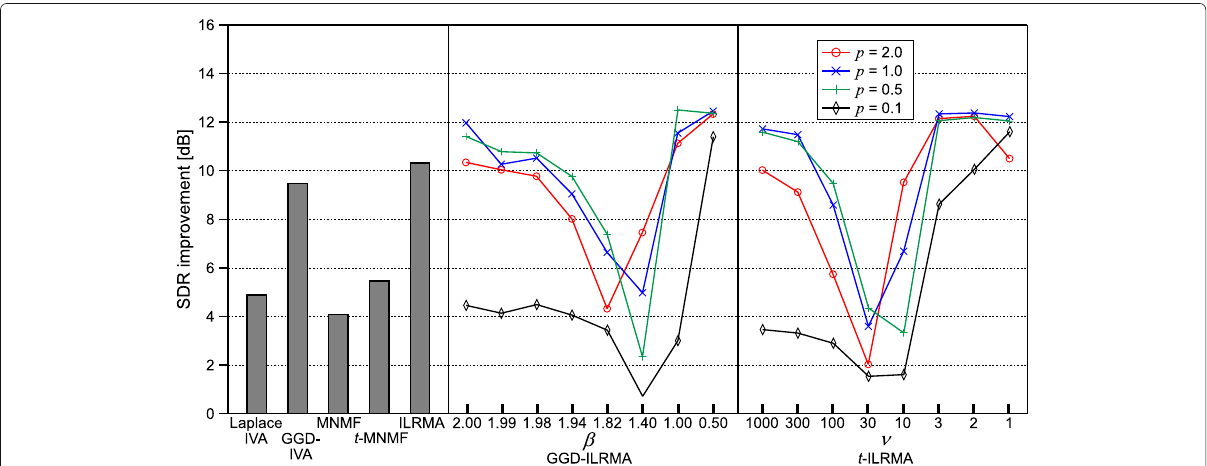
Fig. 8 Average SDR improvements of Music 4 with E2A_1 signal using fixed parameters. The results for GGD-IVA and t -MNMF using β = 0.5 and ν = 30 are shown, which are their best parameter